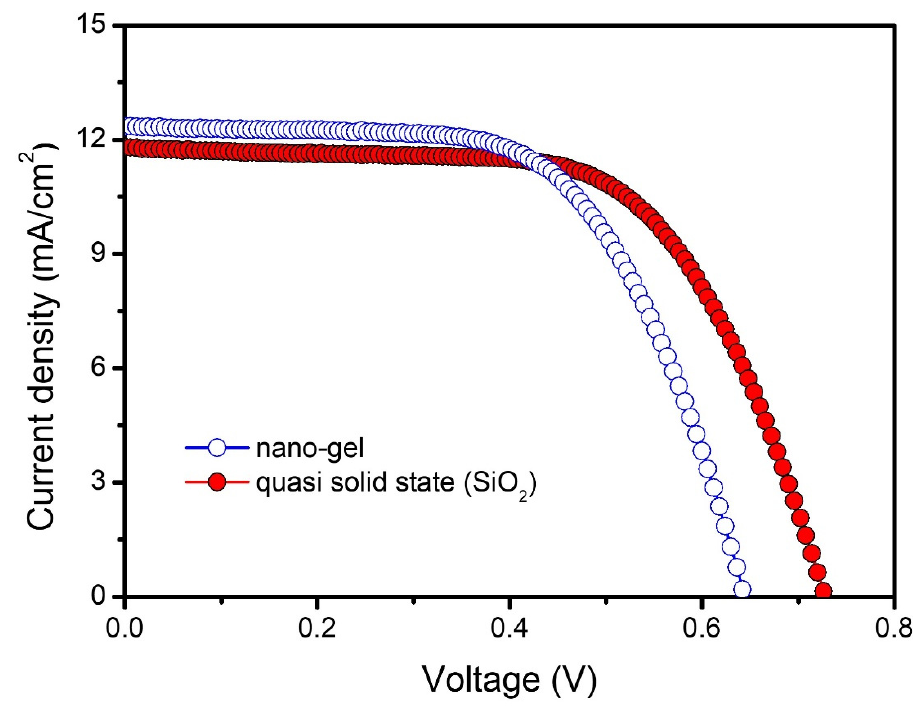
Figure 5. Photocurrent density-photovoltaic curves of DSSCs based on nanogel and quasi-solid-state (SiO 2 ) electrolytes at 100 mW cm − 2 .